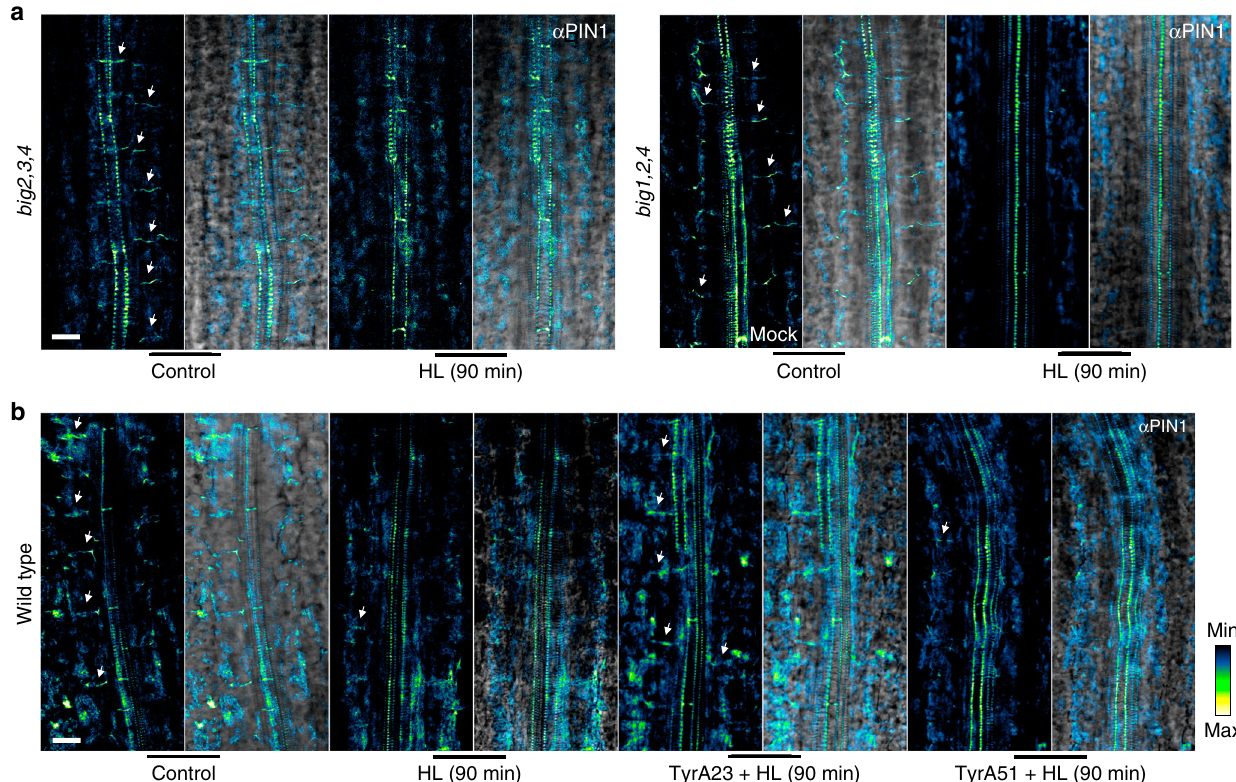
Fig. 6 High light induces clathrin-mediated PIN1 endocytosis. a Representative dark fi eld (left) and bright fi eld (right) images of PIN1 immunolocalization in 7-day old hypocotyls of big2,3,4 and big1,2,4 seedlings before (control) and after 90 min of HL resulting in reduced PIN1 fl uorescence intensity at the PM. b PIN1 immunolocalization dark fi eld (left) and merged image with bright fi eld (right) in 7-day old untreated (control) and 90 min after HL treatment, HL/Tyr23, and HL/TyrA51, showing reduced PIN1 abundance at the PM after HL and HL/TyrA51 treatment but not with HL/TyrA23. The color-coded bar displays the PIN1 fl uorescence intensity. Representative images of two independent experiments, n ≥ 8 biological replicates. Scale bar: 20 μ